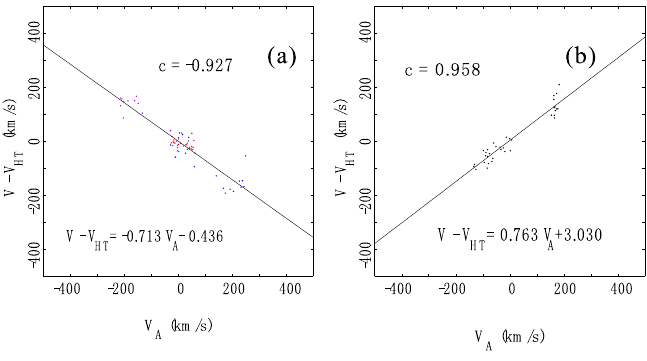
Fig. 2. Wal´en scatter plot for (a) the outbound MP crossing and (b) the inbound MP crossing on 21 March 2004.